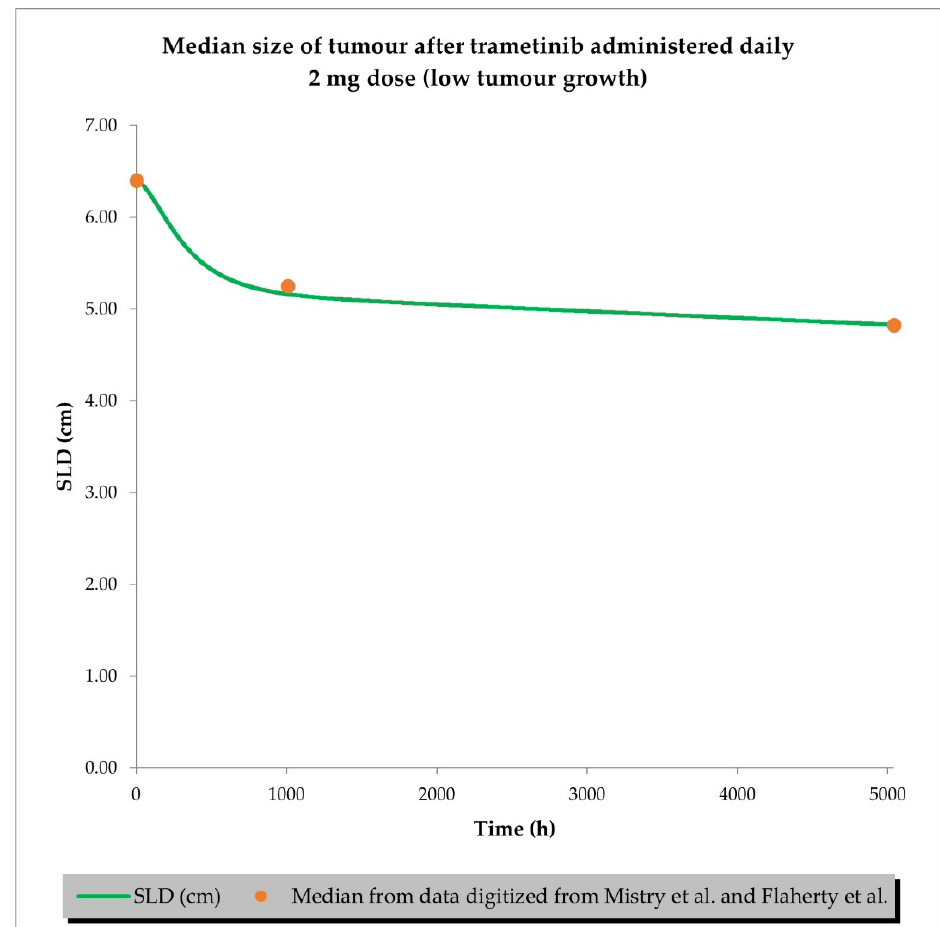
Figure 9. TGI model of trametinib administered daily in cancer patient representatives ( n = 1) with assumption of low tumour growth (kgh = 0.0000261 1/h). Observed data are presented as medians from literature data (data digitised from Mistry et al. [34] and Flaherty et al.